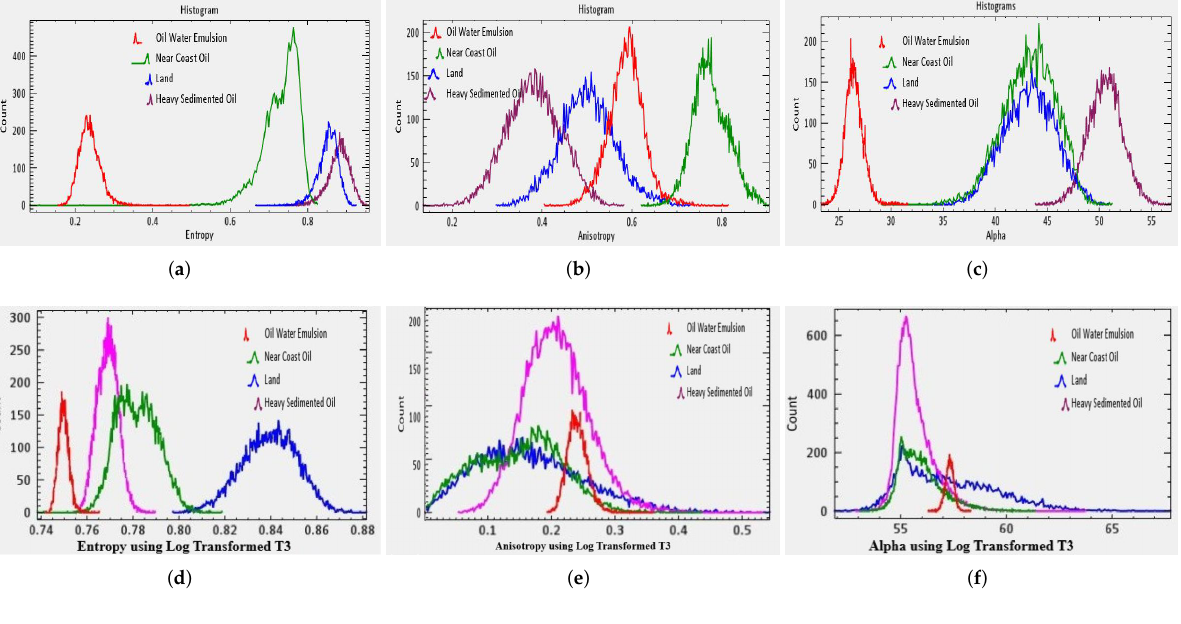
Figure 11. Statistical analysis of results of H / A / α decomposition using conventional T3 and log transformed T3, i.e., Histogram of Entropy H ( a , d ), Anisotropy A ( b , e ) and Scattering Angle α ( c , f ) for different patches showing ranges for Oil water Emulsion (Red), thick Oil (Green), Heavy Sedimented oil (Pink), Land/Mudflat